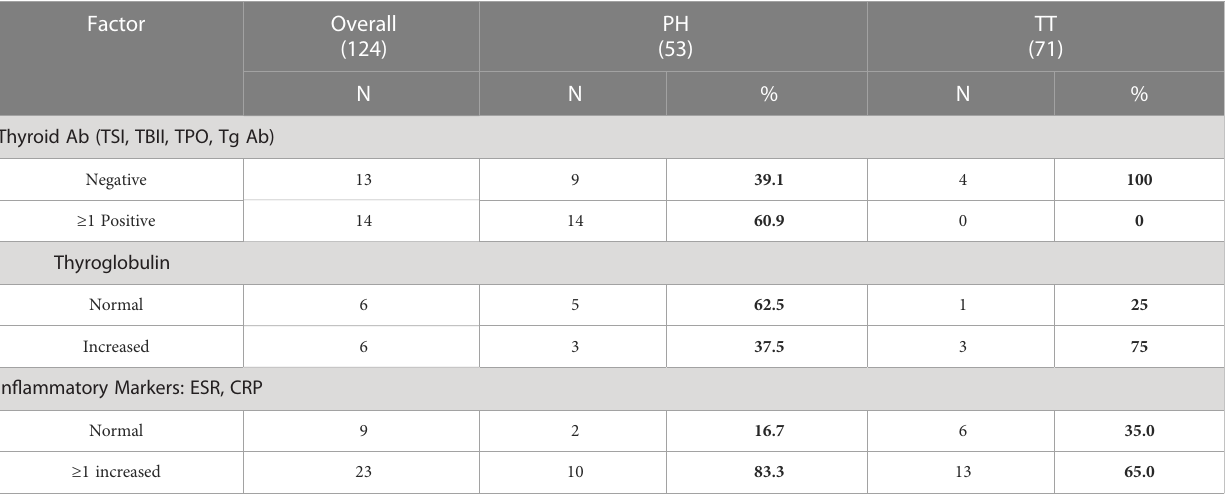
TABLE 2A Laboratory parameters in PH vs